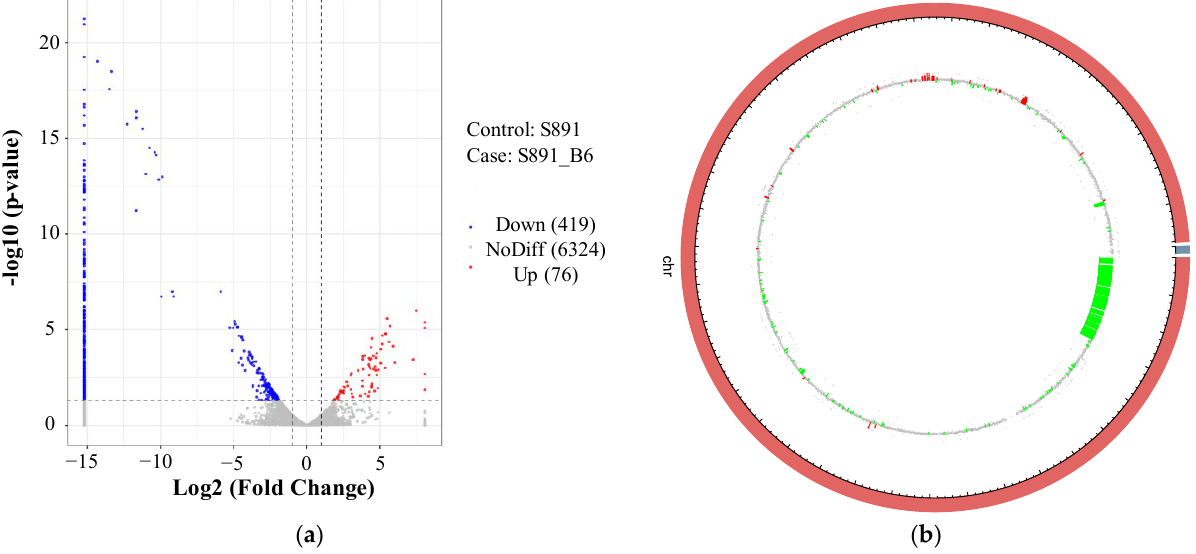
Figure 4. Analysis of DEGs for strain 891-B6: ( a ) the volcano map of the DEGs. Red dots indicate up-regulated genes in this group, blue dots indicate down-regulated genes, and gray dots indicate non-significant genes. ( b ) the genome map of the DEGs. The outer circle is the chromosome band, the red and green bar graphs in the inner circle are up-regulated and down-regulated genes, respectively. The gray dots indicate genes that are not differentially